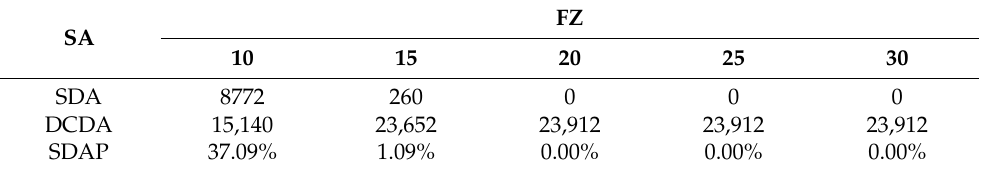
Table 5. Statistical data on the delivery routing of auto parts under various FZ.